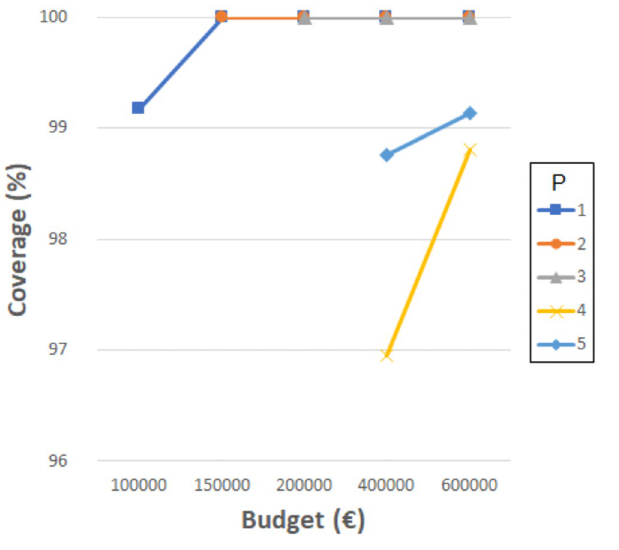
Fig 7. Coverages for 2500